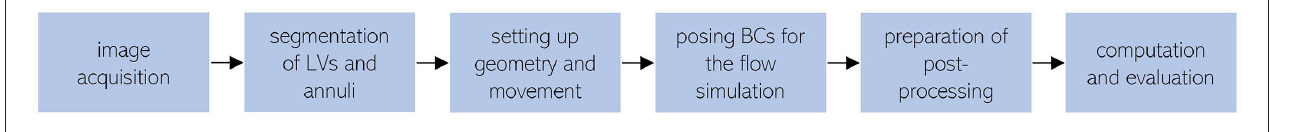
FIGURE 1 | Illustration of the central workflow of the computational framework.